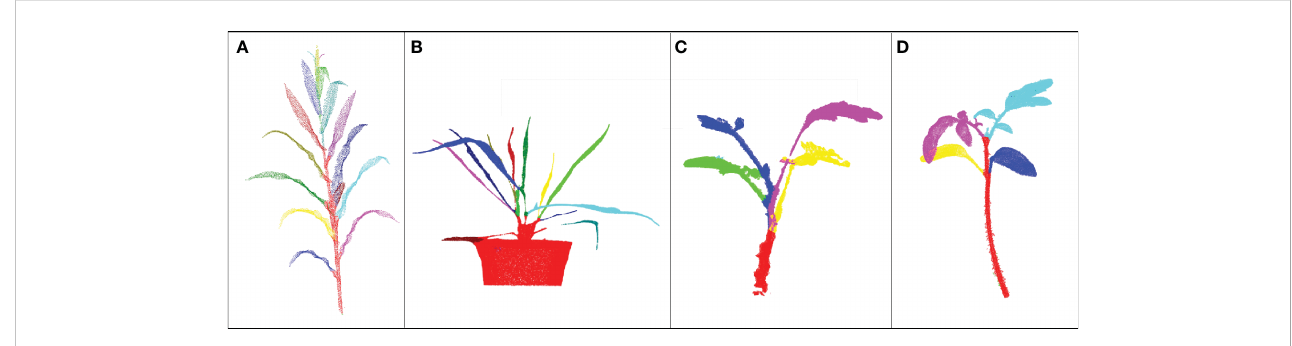
FIGURE 10 The segmentation effect of the median normalized growth segmentation method on different plants. (A) Mature maize (B) Potted wheat (C) Mimosa (D) Eggplant plant.